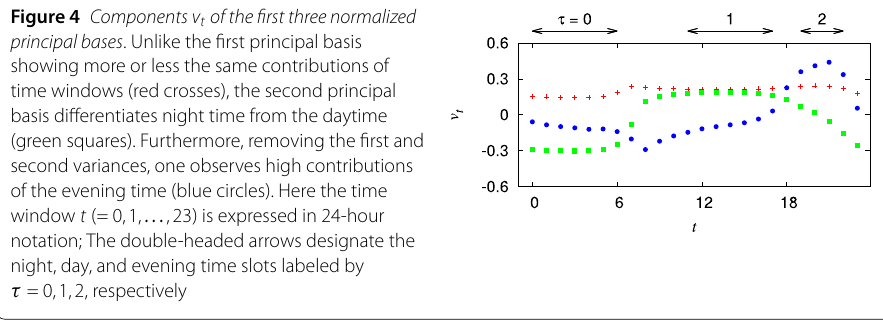
values to the sum of all eigenvalues are given by 0.68, 0.30, and 0.011, respectively. Then the components v t of the corresponding normalized eigenvectors v = ( v 0 , v 1 ,..., v 23 )